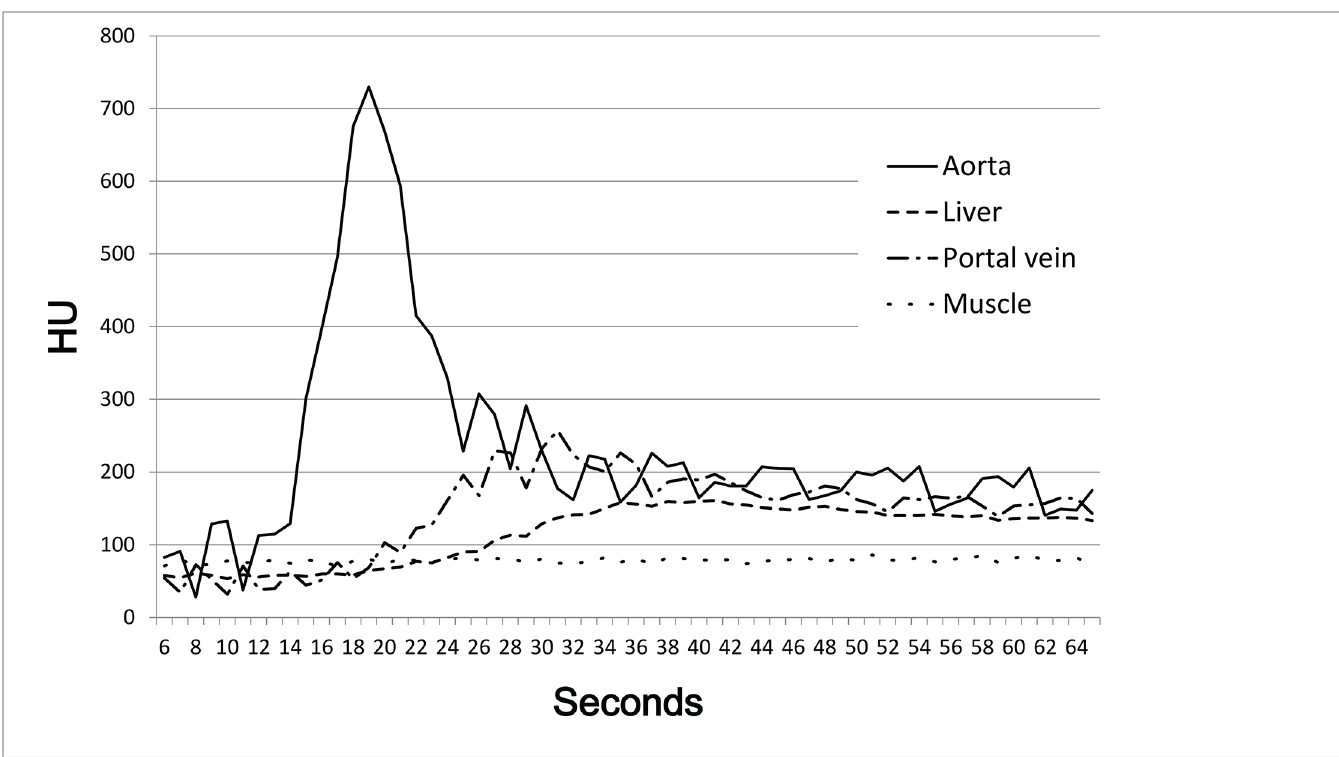
Fig 1. Aorta and liver showed peak enhancement at 19 seconds and 38 – 41 seconds after the initiation of the contrast media administration,